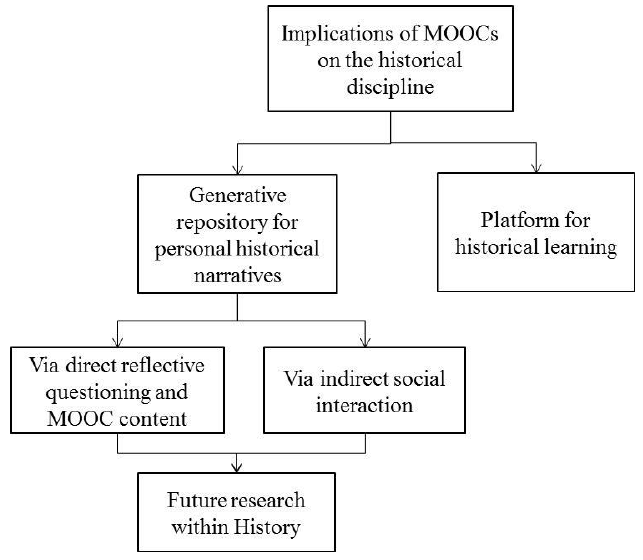
Figure 3 . Implications of MOOCs on the historical